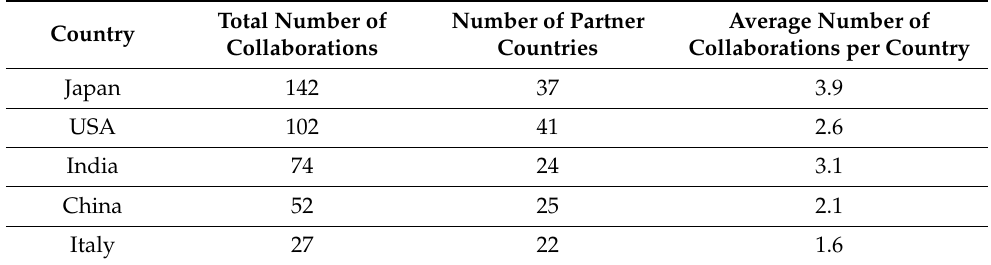
Table 3. Collaborations among